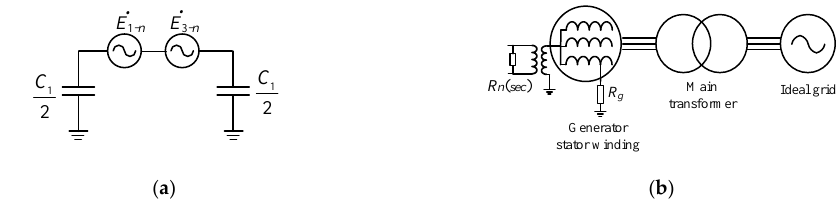
Figure 8. Simplified diagram of the simulation model. ( a ) Simplified model of single turn winding; ( b ) structural diagram of stator ground simulation.